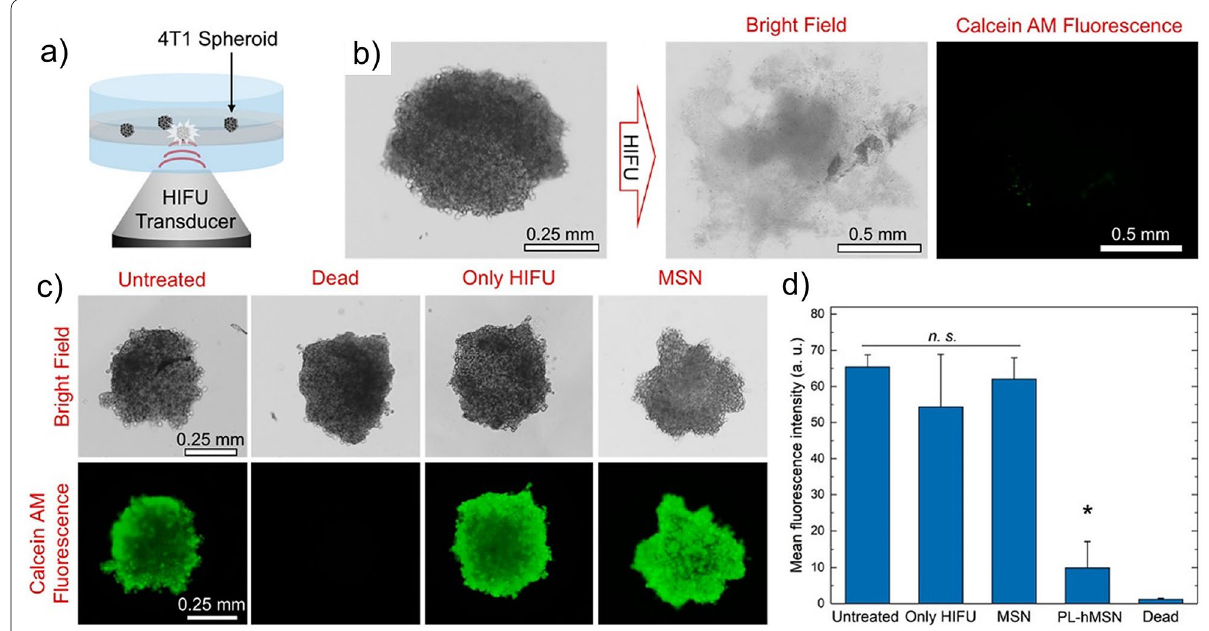
Fig. 8 Ablation of tumor spheroids using HIFU and GSNs. a Schematic of the experimental setup. b Bright field and fluorescence images of a Calcein AM stained spheroid before and after HIFU treatment. c Representative bright field and fluorescence images of Calcein AM stained spheroids at different conditions: an untreated, a heat treated (dead), a HIFU treated in the absence of GSNs, and HIFU treated in the presence of nonresponsive MSNs. d Mean fluorescence intensities for spheroids treated at different conditions. Adapted from reference [46], Copyright 2018, American Chemical Society